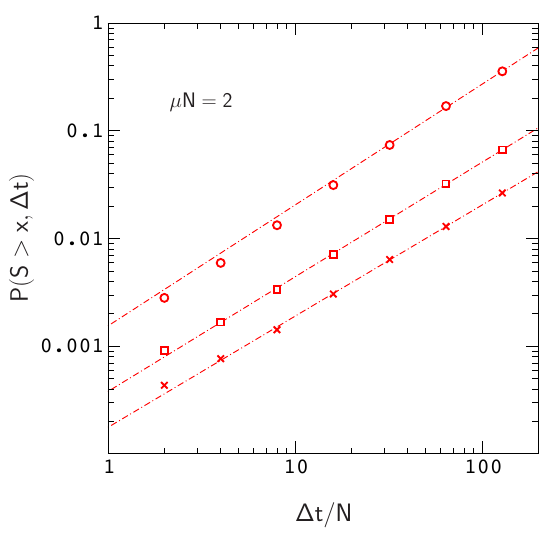
Figure 3. P ( S > x , ∆ t ) versus ∆ t for x (cid:39) 9.1 (circles), 17.8 (squares) and 27.8 (crosses). The results describe proteins with 16 amino acids folding to the native conformation in Figure S5. Each data point is determined from over 10 5 allele histories. The range of the plot, ∆ t ≤ 128 N , corresponds to the time scale of human evolution (about six million years). The dashed lines (power law fits to the data) are very close to linear, increasingly so for larger values of x (see Appendix A for more